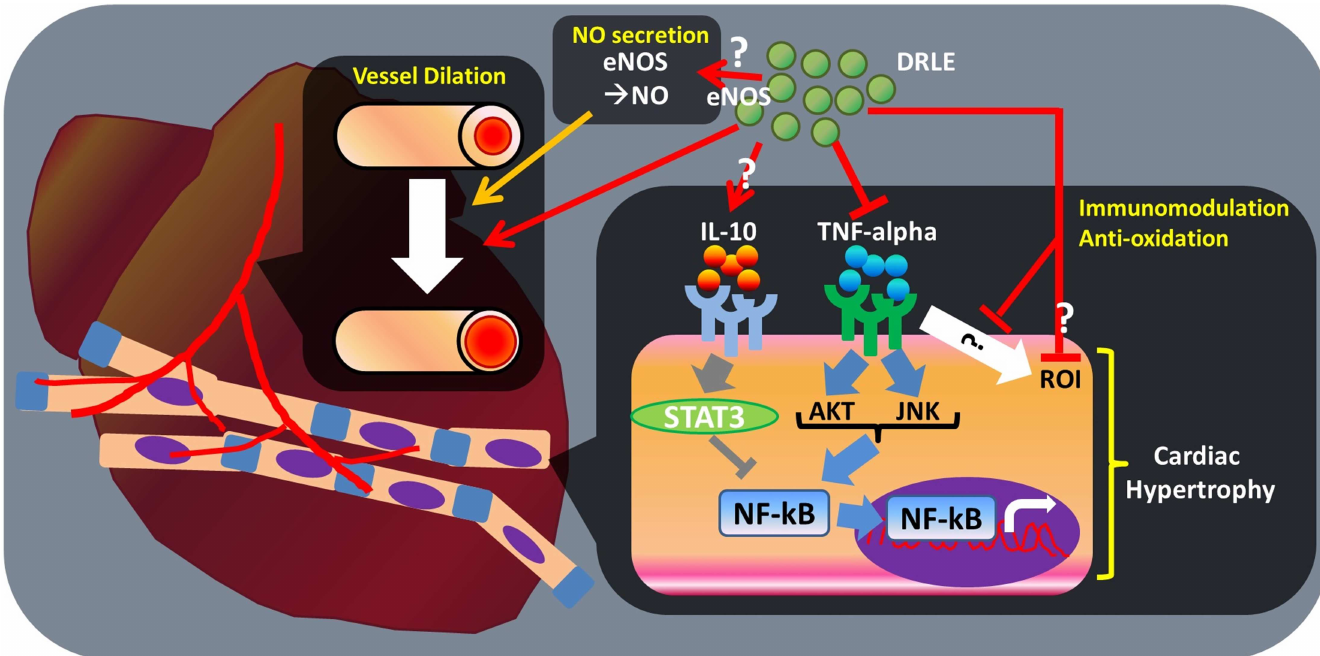
Fig 6. Possible cardioprotective mechanism of DRLE. Inflammation, oxidation,and NO secretionhave been demonstrated to play a critical role in cardiac hypertrophy and myocardialinjury. IL-10 can activate STAT3 to inhibit the NF-kB signalling pathway, thereby attenuatingcardiachypertrophy. TNF- alpha is associatedwith the AKT and JNK pathwaysin enhancingNF-kB activationto augmentcardiachypertrophy. TNF-alphacan also upregulate ROI expressionto enhancemyocyte hypertrophy. Another study reportedthat eNOS upregulation can attenuatemyocardialinjury. In our study, we first found that DRLE can attenuateTNF-alphasecretion, which might reduce AKT, JNK, and NF-kB signallingpathways, thereby inhibitingcardiac hypertrophy. ROI expressionmight also be inhibitedby DRLE through TNF-alphastimulation. We assumed that the direct inhibitionof ROI is a potential mechanismfor inhibitingcardiac hypertrophy, becausethe antioxidative effect of DRLE has also been reported. Second, we cannot confirm whetherDRLE enhances IL-10 expression, becauseserum IL-10 level was undetected in our experiment. Third, the NO serum level increasedin our study, but we could not determine the origin of the NO, and we postulatedthat eNOS is a possiblecandidate. Finally, we found that DRLE can dilate the porcine coronaryartery directly in vitro